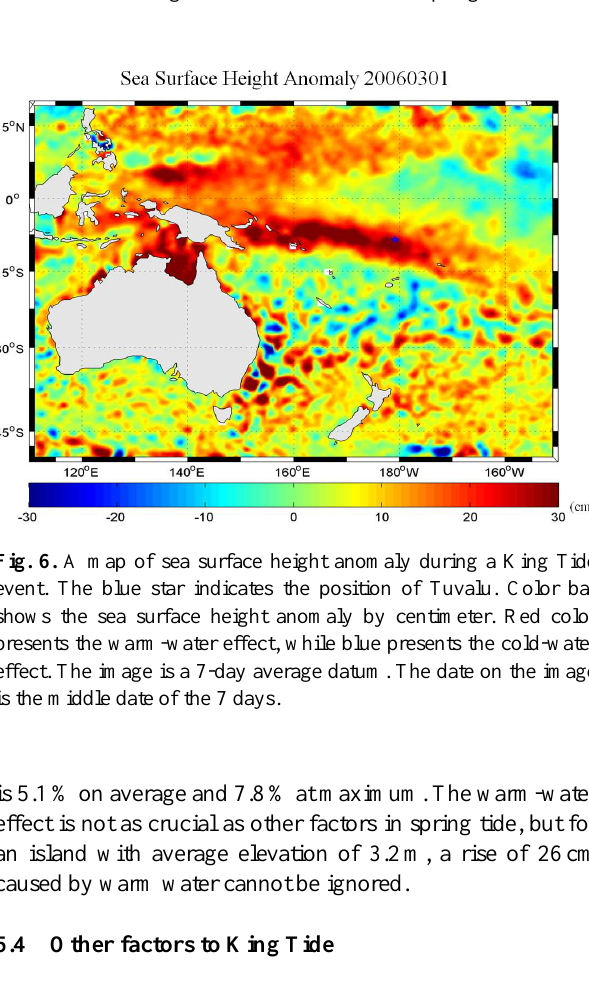
Fig. 5. Time series of sea level variation includes three King Tide events and the usual spring tide. Red line is the threshold of King Tide. There are three King Tide events and one usual spring tide from 15 January to 30 April 2011.